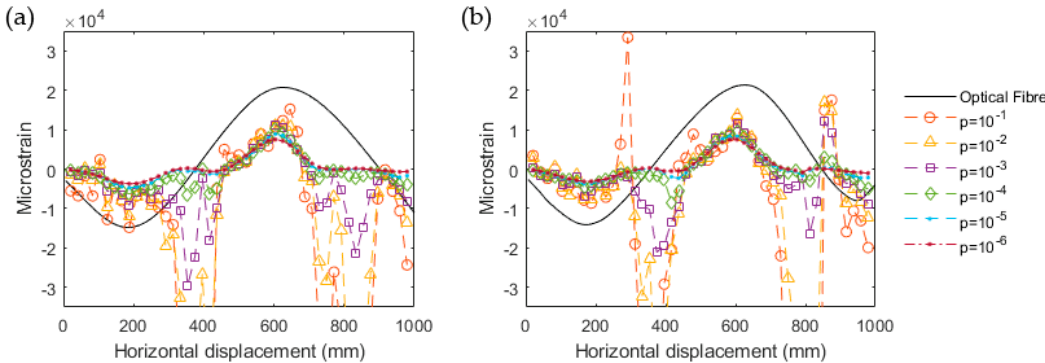
Figure 17. In-plane deformation test Step 2 strain ( a ) at 180 mm and ( b ) 320 mm of optical fibre and different cubic smoothing spline weighting parameter from 10 (cid:2879)(cid:2869) to 10 (cid:2879)(cid:2874) .